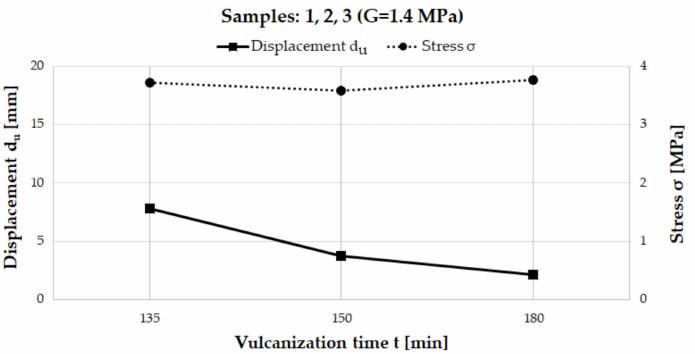
Figure 13. Test results in terms of displacement and stress for samples 1, 2, 3 (G = 1.4 MPa) for various vulcanization times.